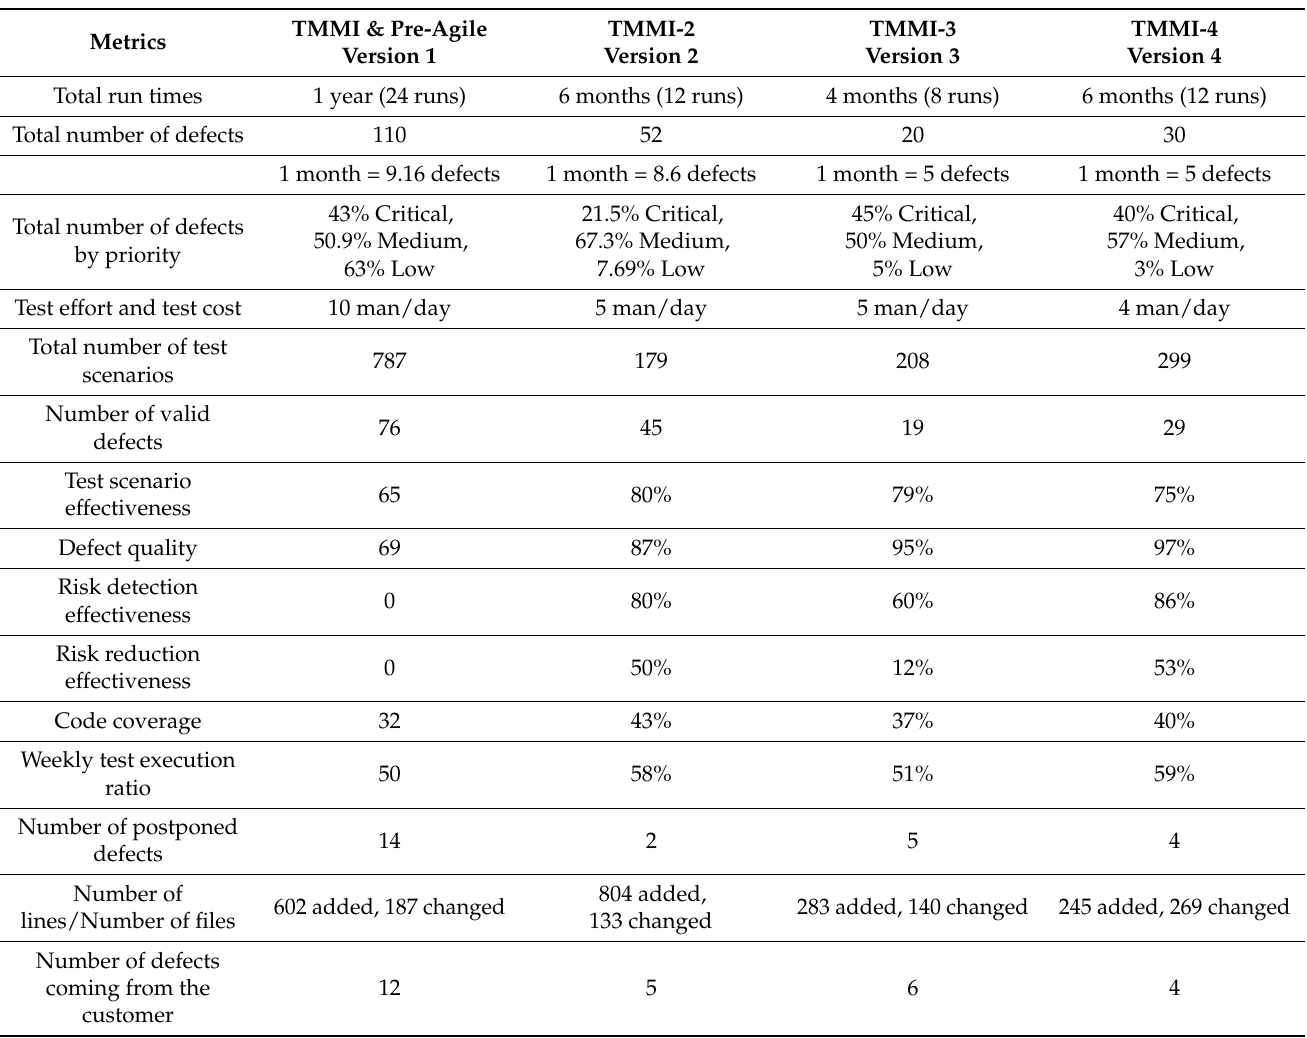
Table 4. Measurement of the metrics after TMMI—Agile process